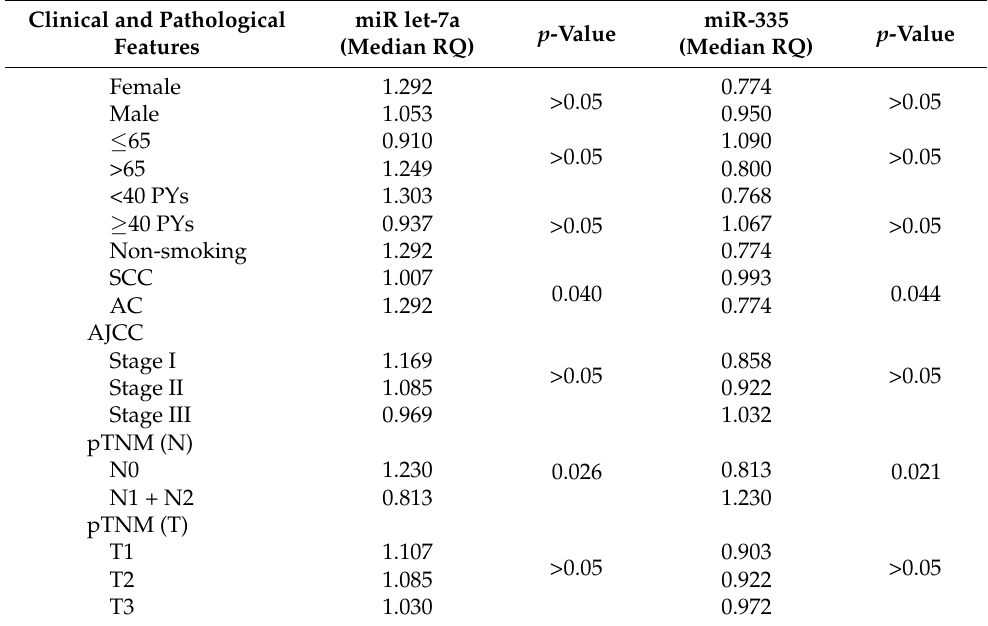
Table 3. Clinical and pathological features: median expression level (RQ value) of evaluated miRNAs in serum